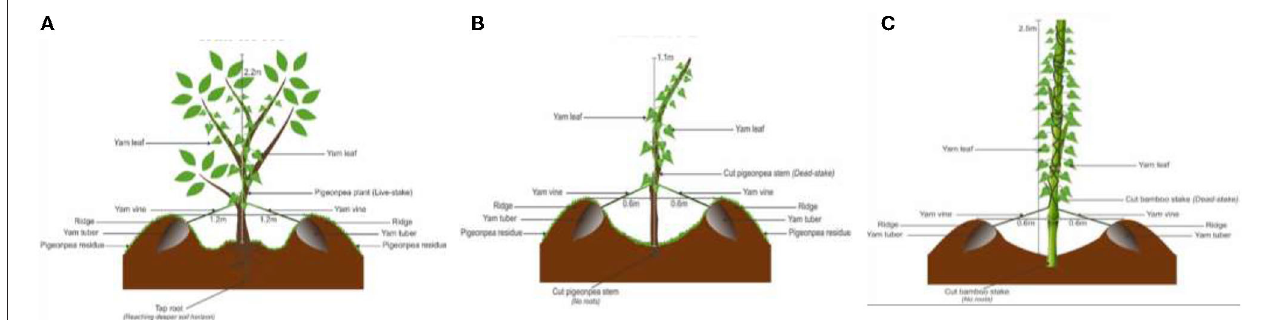
FIGURE 6 | A pictorial illustration of the staking options with pigeonpea in the pigeonpea–yam cropping system options compared with current farmers’ practice. (A) pigeonpea live-staking option for yam in an alley of pigeonpea; (B) Cut pigeonpea stem staking option for two-third field and one-third field for yam and pigeonpea cultivation, respectively; (C) Farmer practice of using bamboo staking option; bamboo stakes purchased and transported to yam fields ( Source: Owusu Danquah,